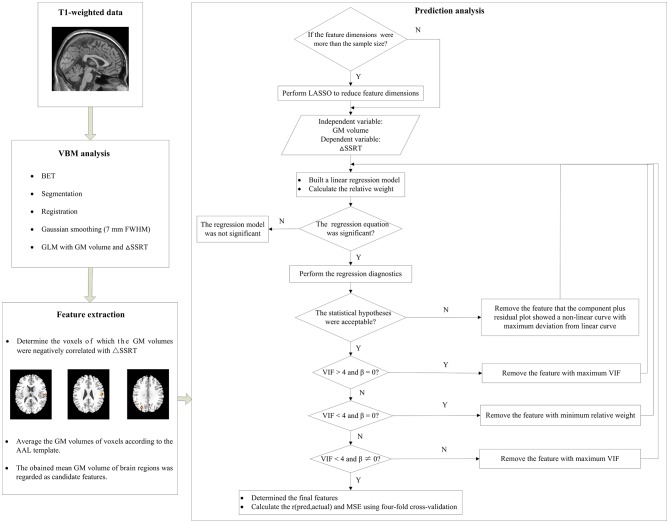
A schematic diagram of the prediction analysis pipeline. First, the T1-weighted data underwent the voxel-basedmorphometry (VBM) analysis to find the relationship between gray matter (GM) volume and ΔSSRT. Second, we extracted features from the results of the VBM analysis, and determined the voxels which GM volumes were negative correlated with the ΔSSRT at an uncorrected threshold. The GM volumes of voxels were then averaged according to the automated anatomical labeling (AAL) template. The obtained mean GM volumes of brain regions were regarded as candidate features. Third, we used these candidate features to predict the ΔSSRT with a linear regression model. If the feature dimensions were higher than the sample size, we performed least absolute shrinkage and selection operator (LASSO) to reduce the feature dimensions before building the linear regression model; otherwise, we directly built the linear regression model. We then evaluated the applicability of this model according to the following conditions: (1) the regression model was significant; (2) the linear regression model met the statistical hypotheses (normality, independence of errors, linearity, and homoscedasticity); (3) the regression coefficients (β) of all features were significant; (4) the features had no multicollinearity. If the model met all of the conditions, we calculated the r(pred, actual) and mean square error (MSE) using the final features; otherwise, features were removed one by one until the model met all the conditions.